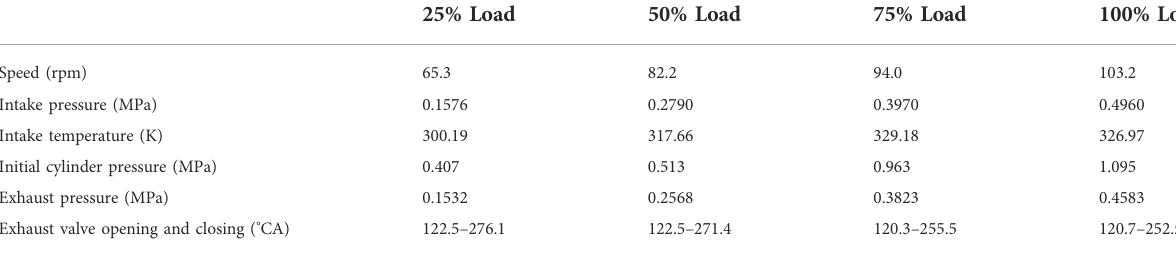
TABLE 7 Input parameter settings of the RTX-8 engine under different load conditions.